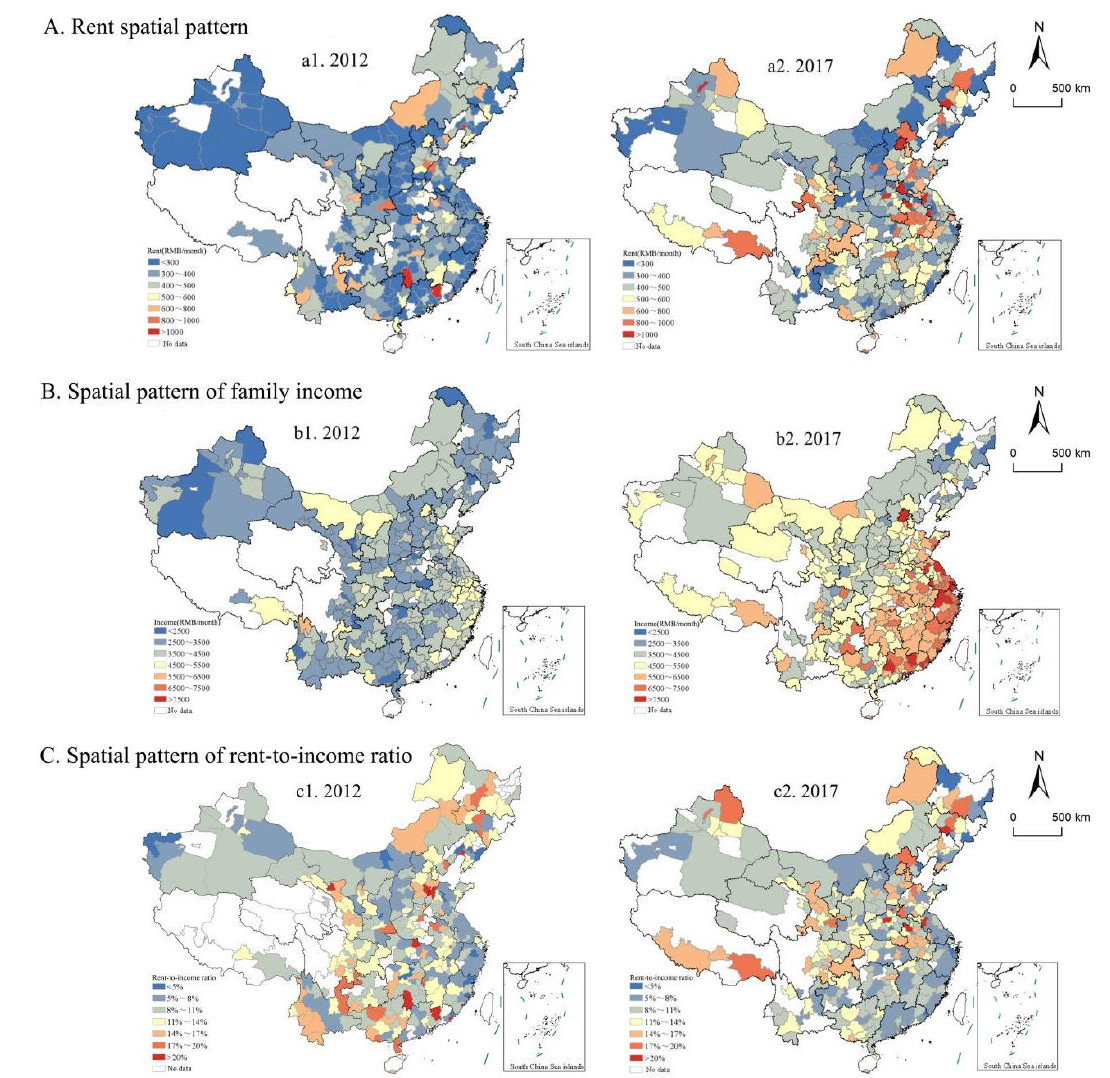
Figure 1. Spatial pattern of rent and family RIR of floating population, 2012 and 2017. Note: This figure is based on the standard map of the standard map service system of the Ministry of Natural Resources of China (review number: GS (2019) 1697), and the base map is not modified.